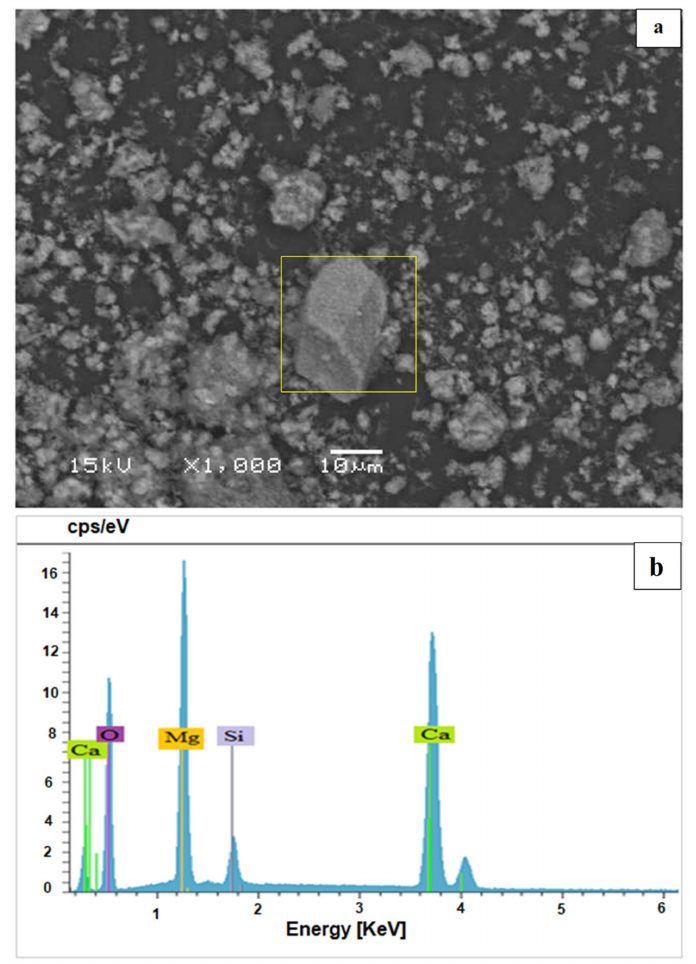
Figure 4. SEM image ( a ) and EDS spectrum ( b ) of dolomitic